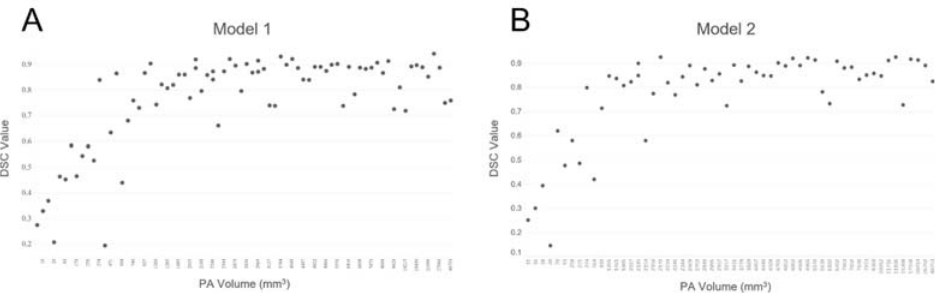
Figure 5. Three cases of small, medium, and large PAs are illustrated in rows. The first column represents the ground truth PA segmentations outlined in red, the second column represents PA segmentations from Model 1, and the third column represents PA segmentations from Model 2.